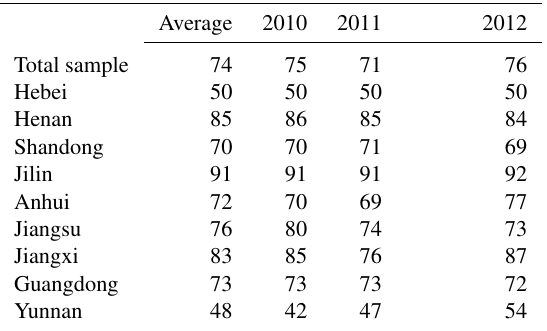
Table 2. Supply reliability of surface water irrigation over 3 years by province in